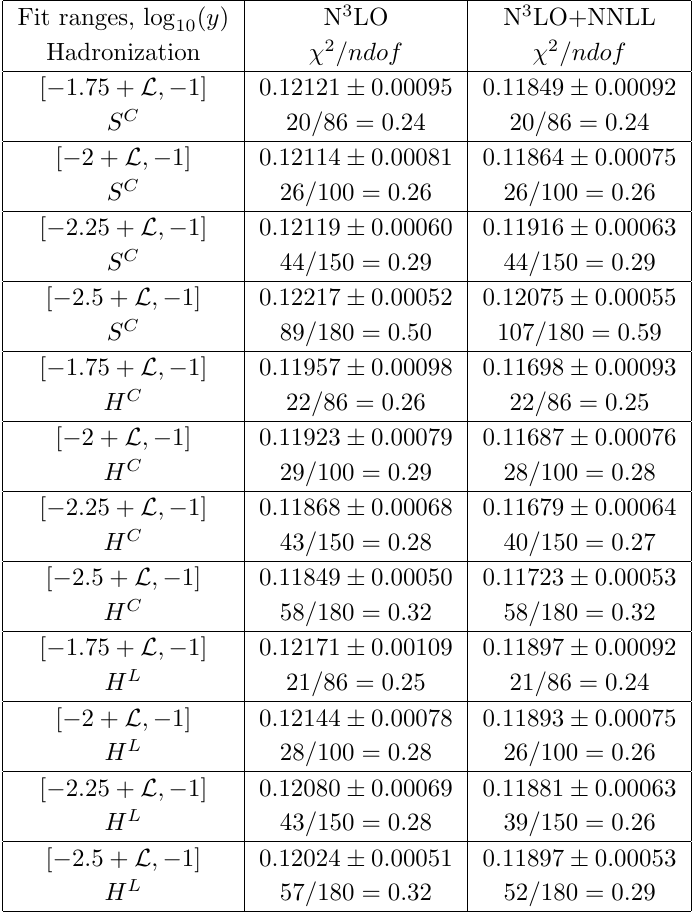
Table 2 . Fit of (cid:11) s ( M Z ) from experimental data for R 2 obtained using N 3 LO and N 3 LO+NNLL predictions, three di(cid:11)erent hadronization models and four di(cid:11)erent choices of the (cid:12)t range, as given in the brackets, with L = log ( M 2 =Q 2 ). The reported uncertainty is the (cid:12)t uncertainty as given 10 Z by MINUIT2